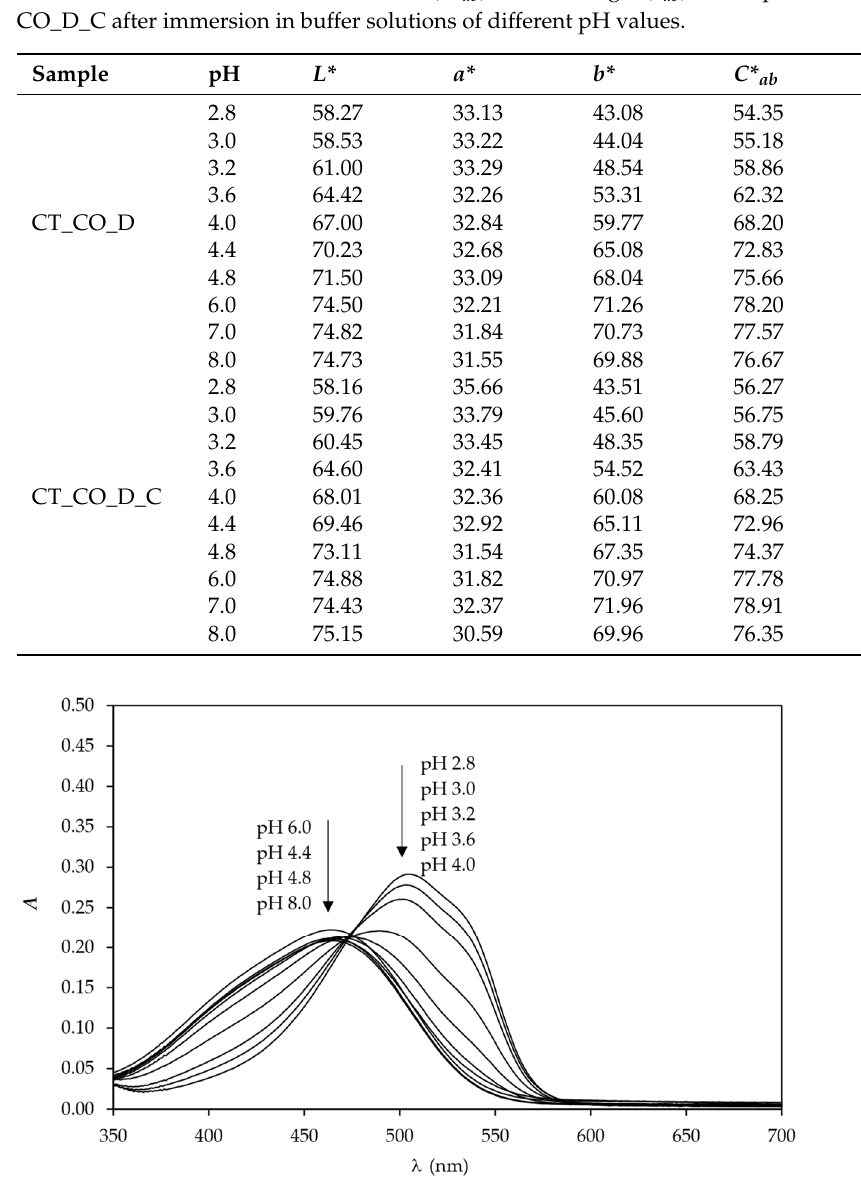
Figure 9. Absorption spectra of dye MO in buffer solutions of different pH values.